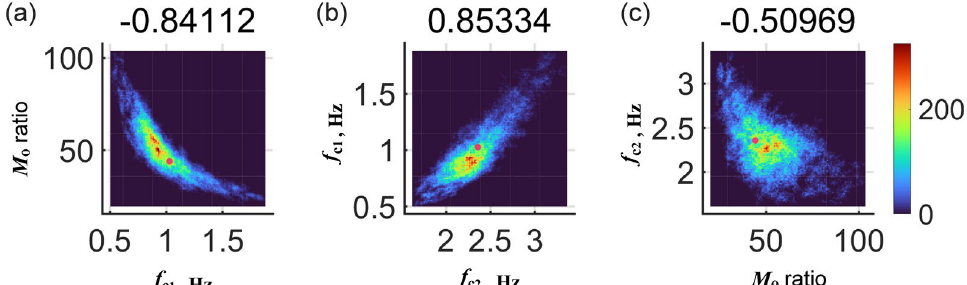
Fig. 6. 2D histogram based on sampling distribution. Color scales indicate the density of the sample. Pink circles indicate the highest likelihood values from the F -distribution. The value displayed on each panel indicates the correlation